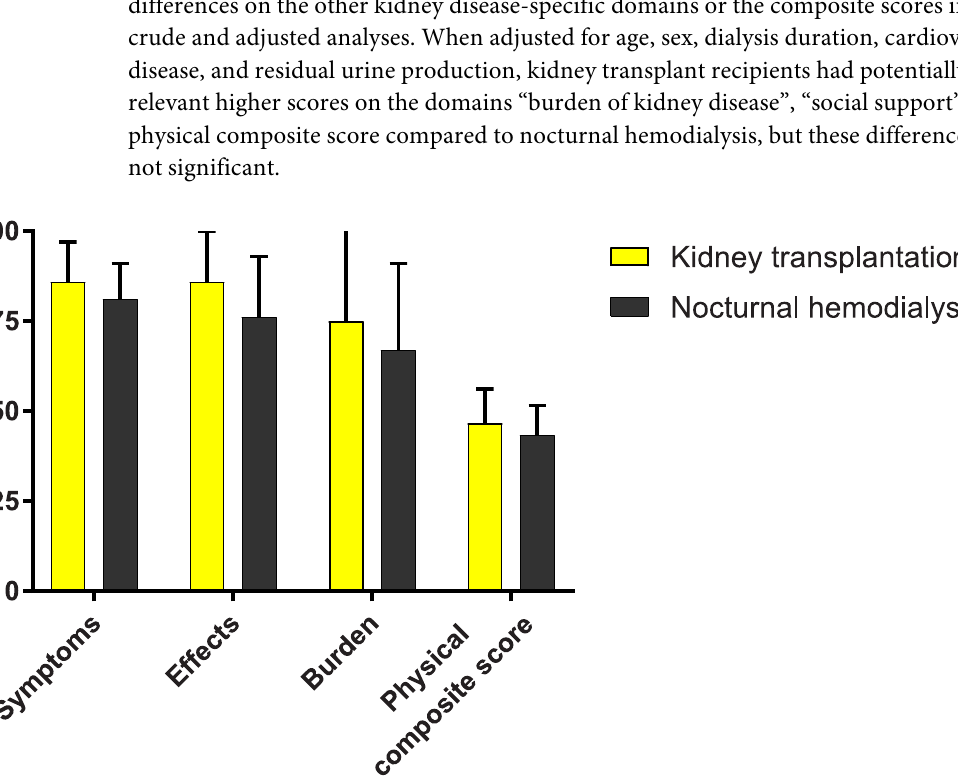
Fig 1. Disease-specific health-related quality of life scores and physical composite scores in the 72 kidney transplant recipients and patients on nocturnal hemodialysis. Mean health-related quality of life scores on the disease-specific domains “symptoms”, “effects”, “burden of kidney disease”, and the physical composite scores as bar charts in the 72 kidney transplant recipients and patients on nocturnal hemodialysis. We presented 95% confidence intervals alongside the bars. Mean scores for kidney transplantation and nocturnal hemodialysis: “symptoms” 86 and 81; “effects” 86 and 76; “burden” 75 and 67; physical composite score 47 and 43 points,